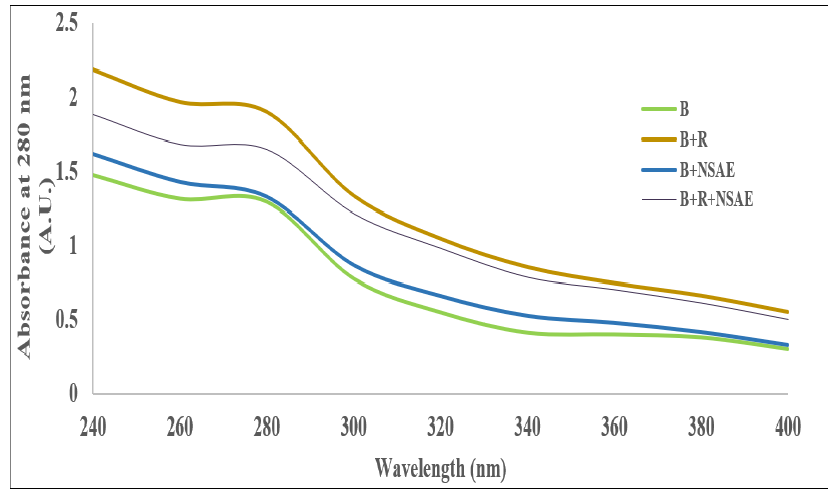
Figure 2. Effect of N. sativa seed extract on D-ribose glycation-induced change in the hyperchromic- ity pattern. The decrease in absorption was observed in the presence of NSAE.